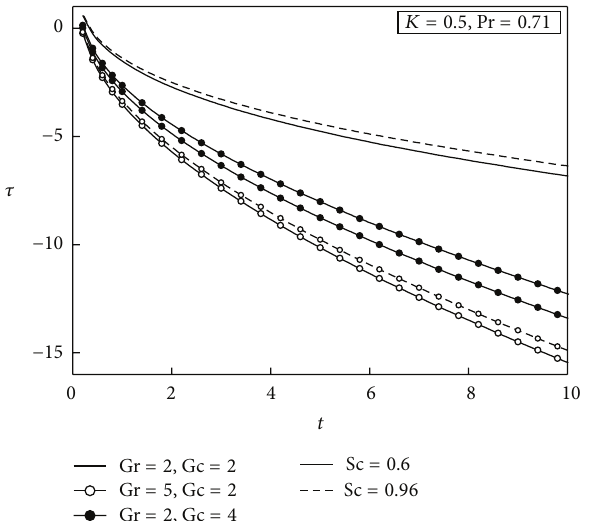
Figure12:Effectsof 𝐾 andScontheSherwoodnumberwithrespect to